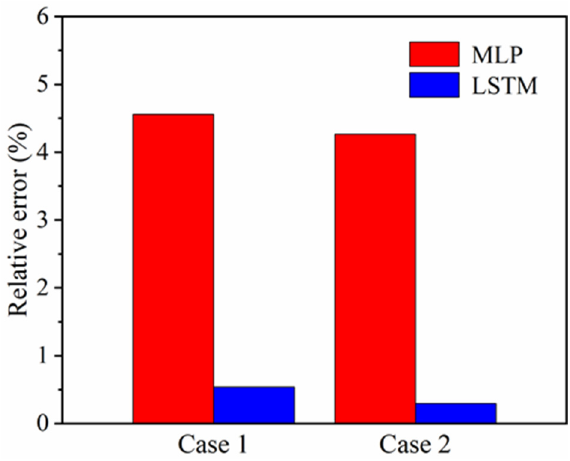
Figure 8. Relative error between the predictive value and true value of the MLP and LSTM net- works.